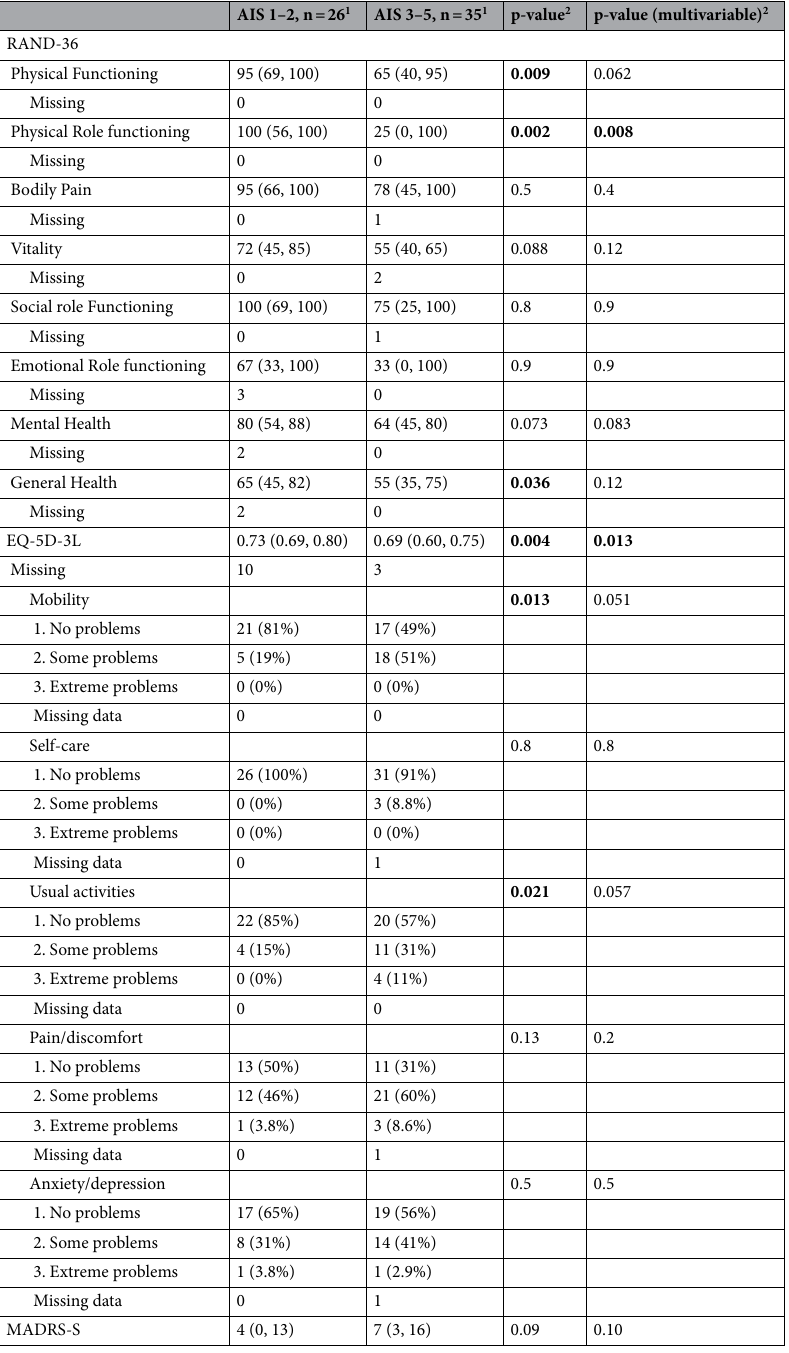
Table 3. Results AIS in TBI. Comparing health-related quality of life (HRQoL), assessed with RAND-36 and EQ-5D, and symptoms of depression assessed with Montgomery Åsberg depression Rating Scale self-report (MADRS-S), in TBI patients with AIS head 1–2 to TBI patients with AIS head 3–5. 1. n (%); Median (IQR), 2. Ordered logit. Significant values are in bold. *Significant after Bonferroni